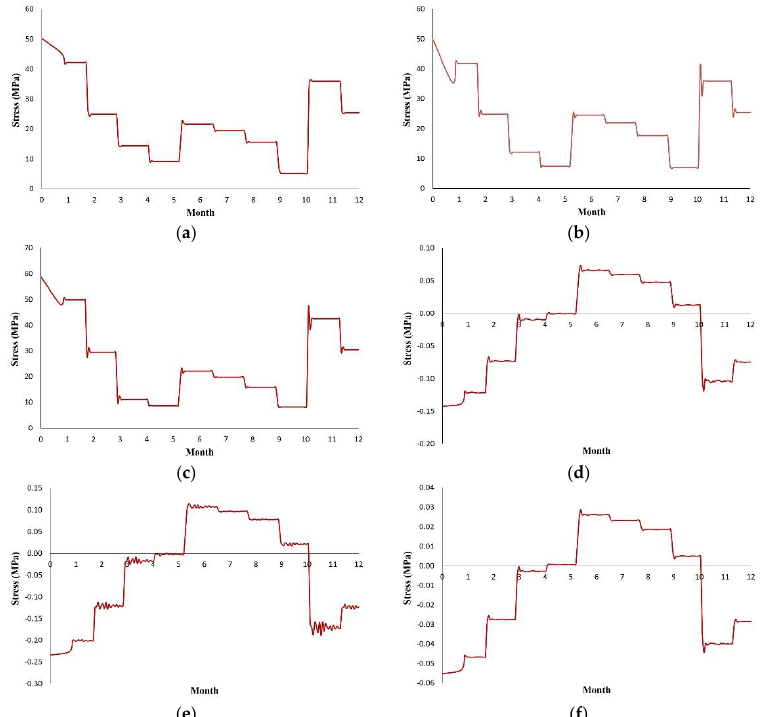
Figure 11. Time histories of stress tensor components in the critical region due to small temperature variations, including ( a ) normal stress in X-direction, ( b ) normal stress in Y-direction, ( c ) normal stress in Z-direction, ( d ) shear stress in XY-plane, ( e ) shear stress in YZ-plane, and ( f ) shear stress in XZ- plane.